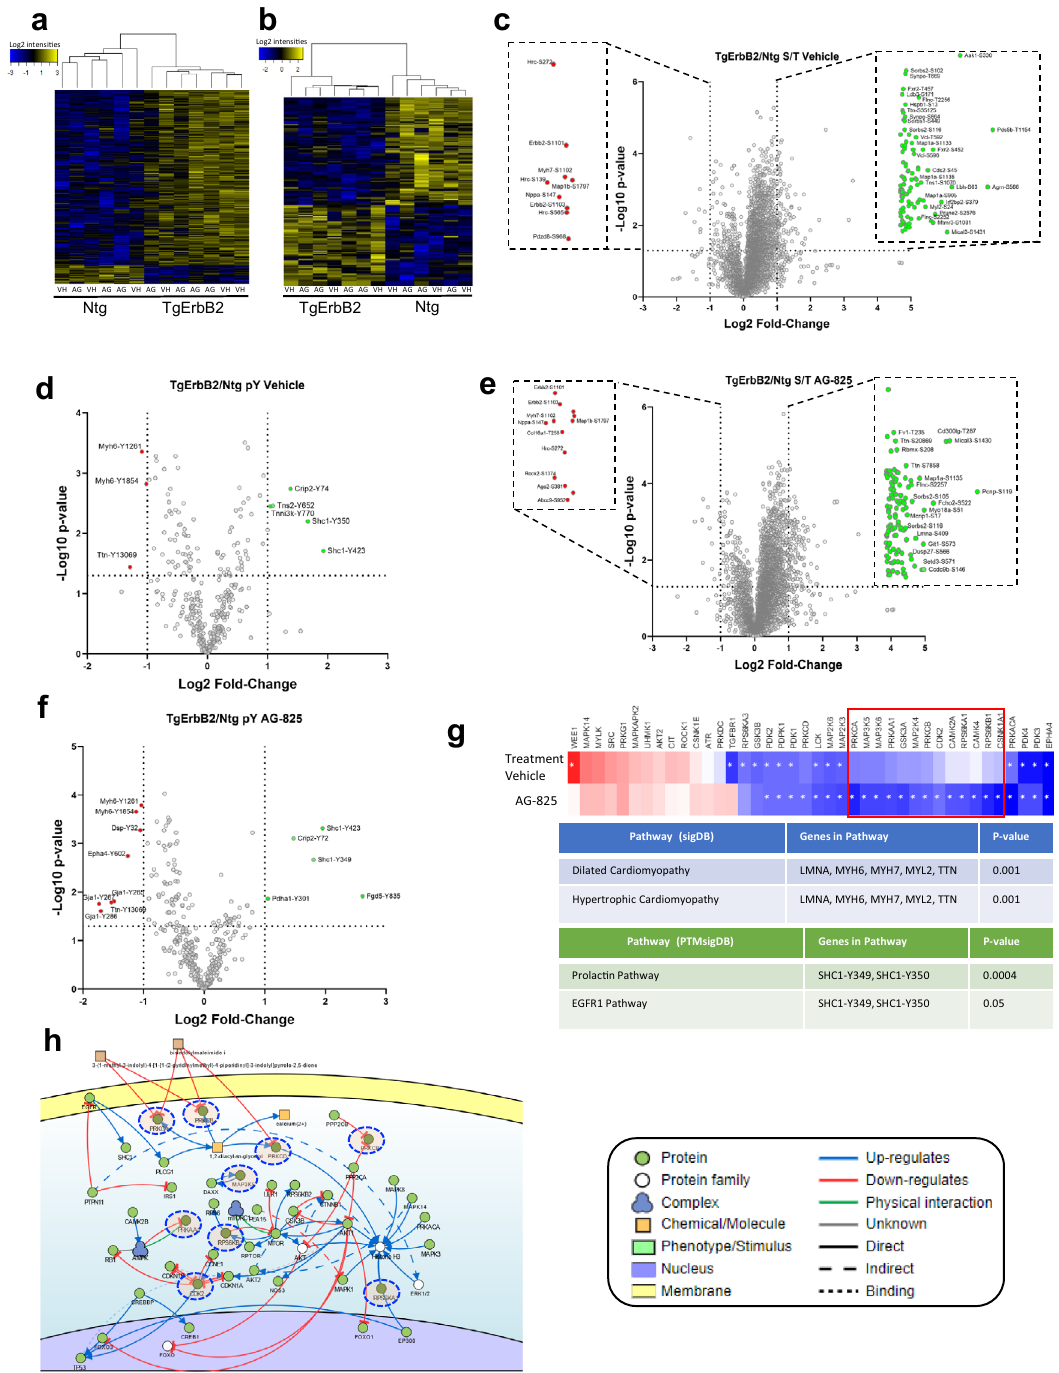
Fig. 8 Comprehensive serine/threonine/tyrosine phosphoproteomics con fi rm EGFR1 pathway involvement in TgErbB2 hypertrophy and tyrosine kinase receptor inhibition by AG-825. a A heatmap was used to visualize the unsupervised hierarchical clustering of Ser/Thr peptides, and b pTyrosine peptides normalized to full proteome expression with p -value < 0.05 by ANOVA. Overrepresented (yellow) and underrepresented (Blue). c Volcano plots showing the Log2 fold-change and – Log10 p -value of each pSer/pThr peptide and d pTyr peptides in the pairwise comparison of Ntg and TgErbB2 after two weeks of Vehicle Treatment. e Volcano plots showing the Log2 fold-change and – Log10 p -value of each pSer/pThr peptide and f pTyr peptides in the pairwise comparison of Ntg and TgErbB2 after two weeks of AG-825 Treatment, ( g ) KSEA shows in a red rectangle the kinases signi fi cantly inhibited by AG-825. KSEA and Pathway Enrichment Analysis of combined Ser/Thr/Tyr phosphorylation data analysis using PTMSigDB con fi rm that EGFR1 Pathway is signi fi cantly involved. h The Signaling Network Open Resource (Signor 2.0) analysis shows that nine kinases are involved in the EGFR pathway. Kinases found in the network and also in KSEA are circled in dotted blue circles. The symbol code of the network is displayed next to the